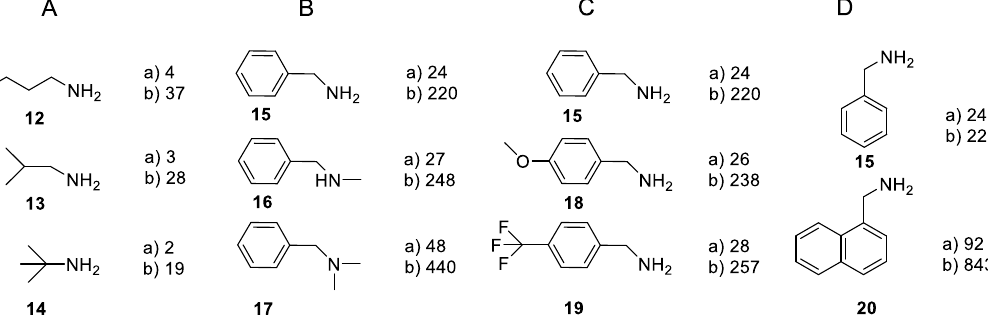
Figure 3. Transported amounts of amines after 20 h of transport time, measuring the ammonium salt